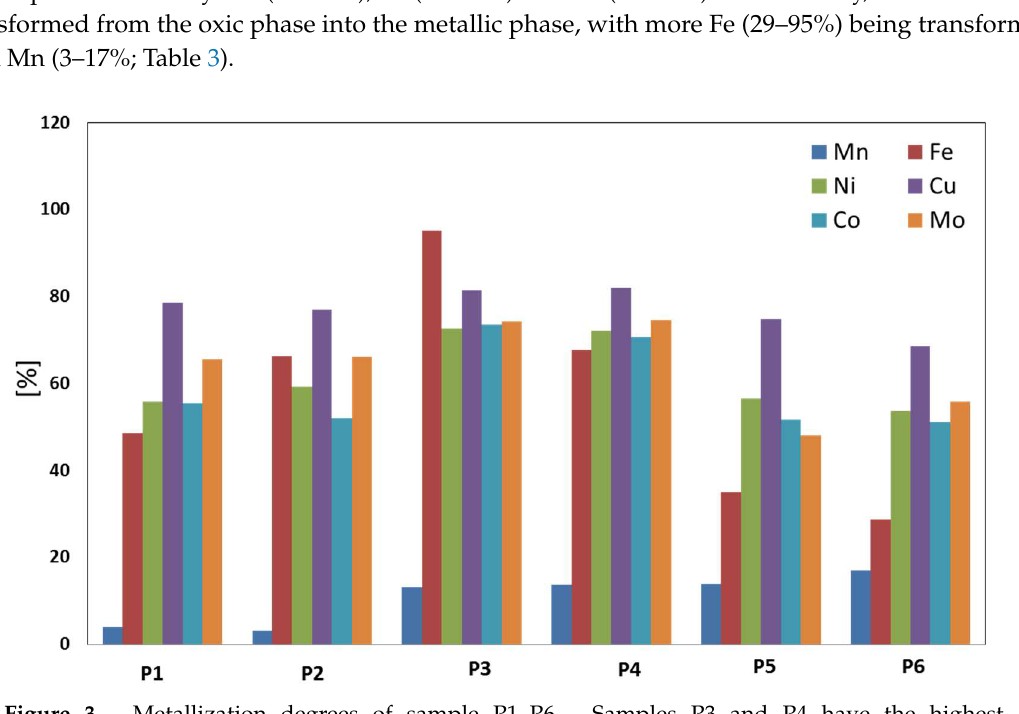
Figure 3. Metallization degrees of sample P1–P6. Samples P3 and P4 have the highest metallization degrees.